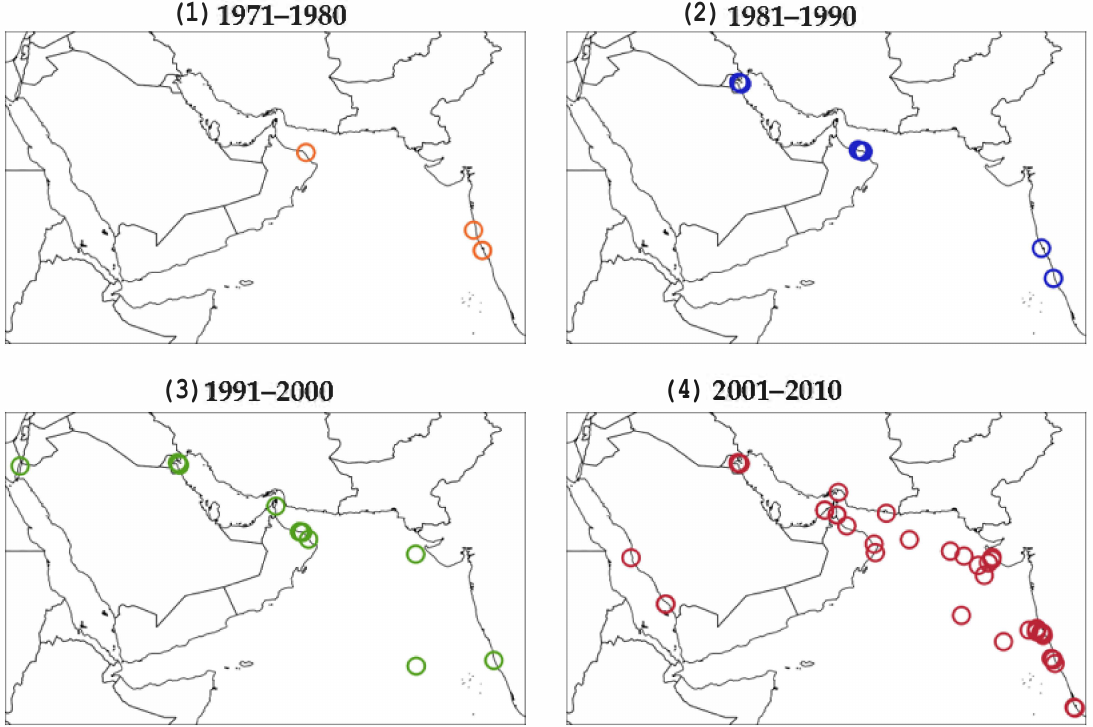
Figure A4. Algal bloom outbreaks in the NIO during March–May over four decades: ( 1 )